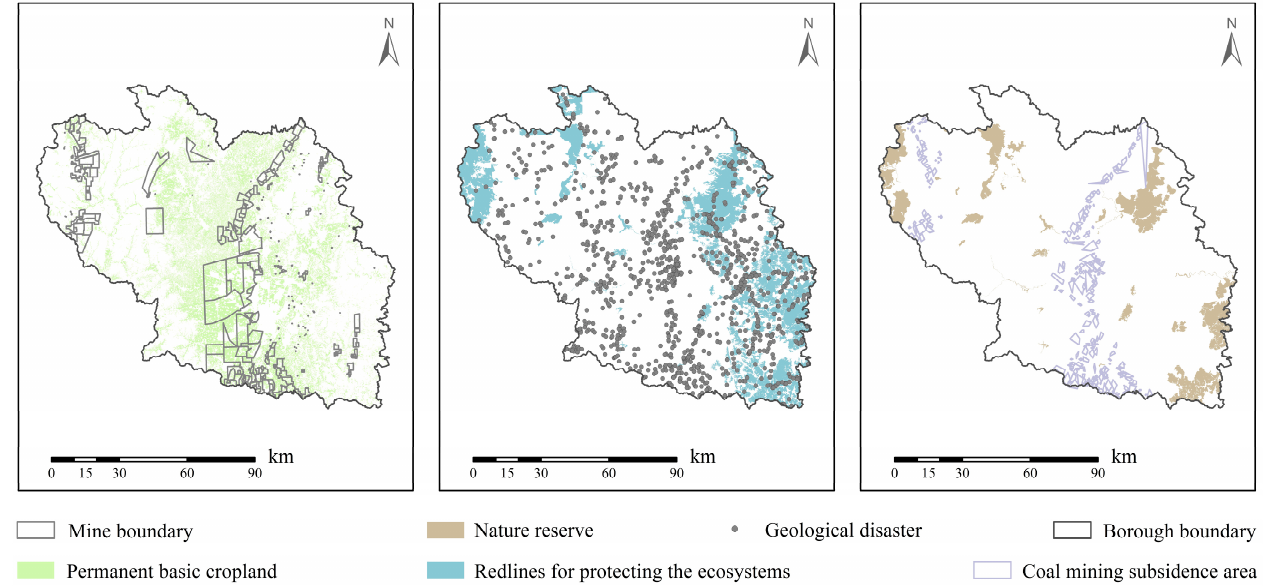
Figure 6. Mining area, basic farmland protection zone, ecological protection zone, nature reserve, geological disaster site, coal mining sinkhole of Changzhi.